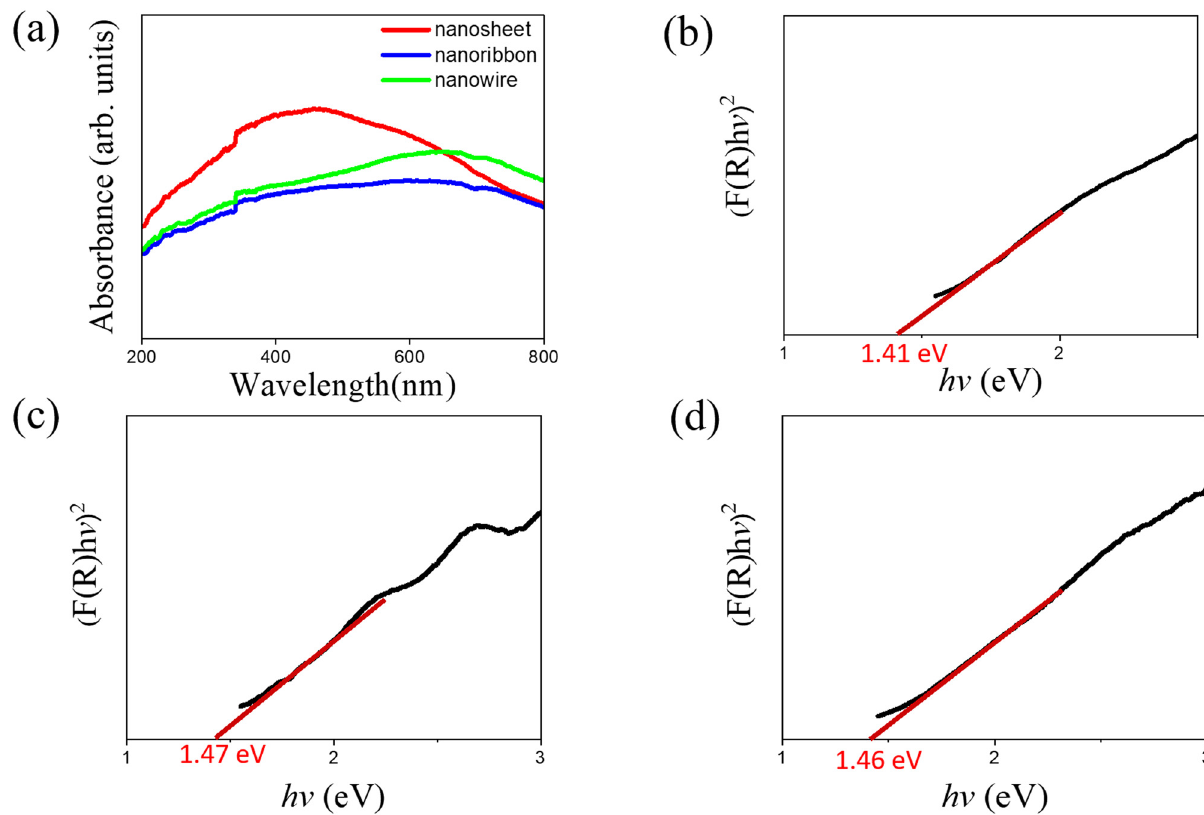
Figure 5: ( a ) Optical absorption spectra of all Bi 2 S 3 products. Band gap evolution of various Bi 2 S 3 products: ( b ) nanosheet, ( c ) nanoribbon, and ( d )